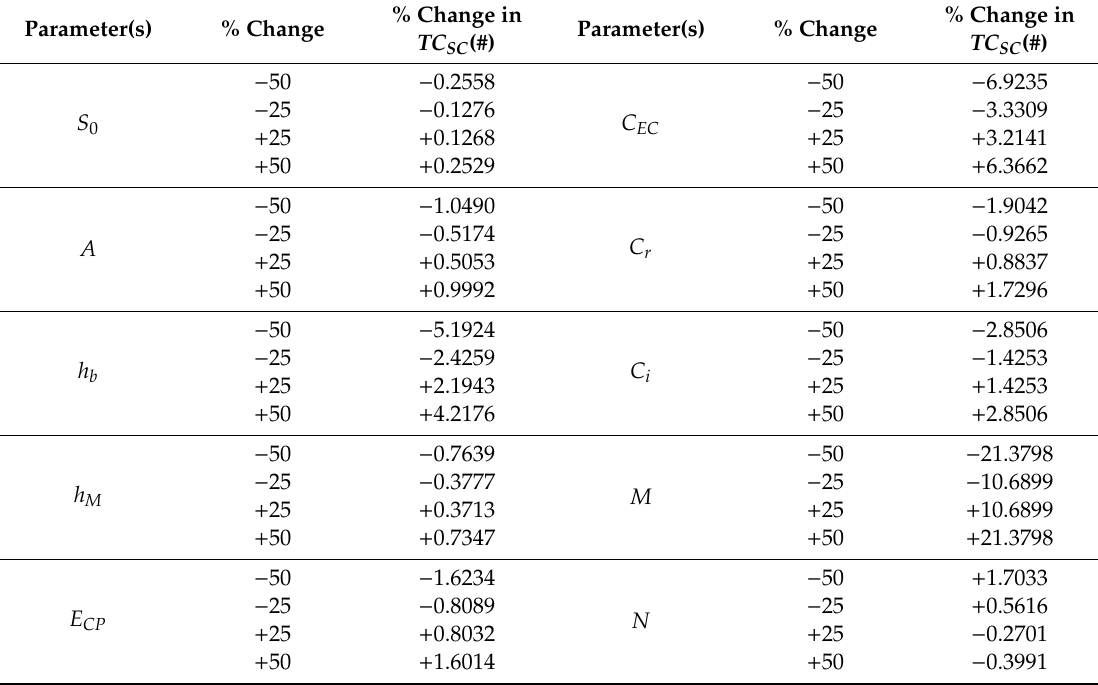
Table 6. Sensitivity analysis for the total SC cost (The Integrated SC for Example